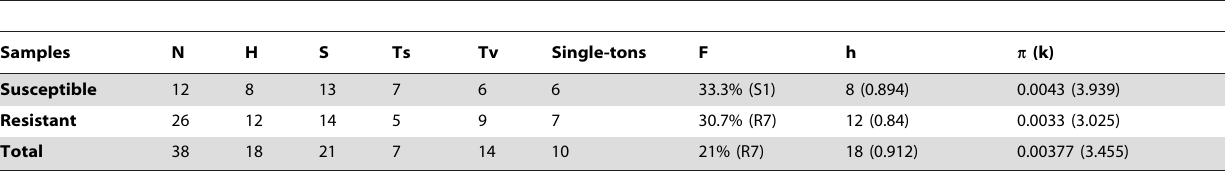
Table 4. Summary statistics for polymorphism at the sodium channel gene in susceptible and resistant An. funestus from Tororo, Uganda.